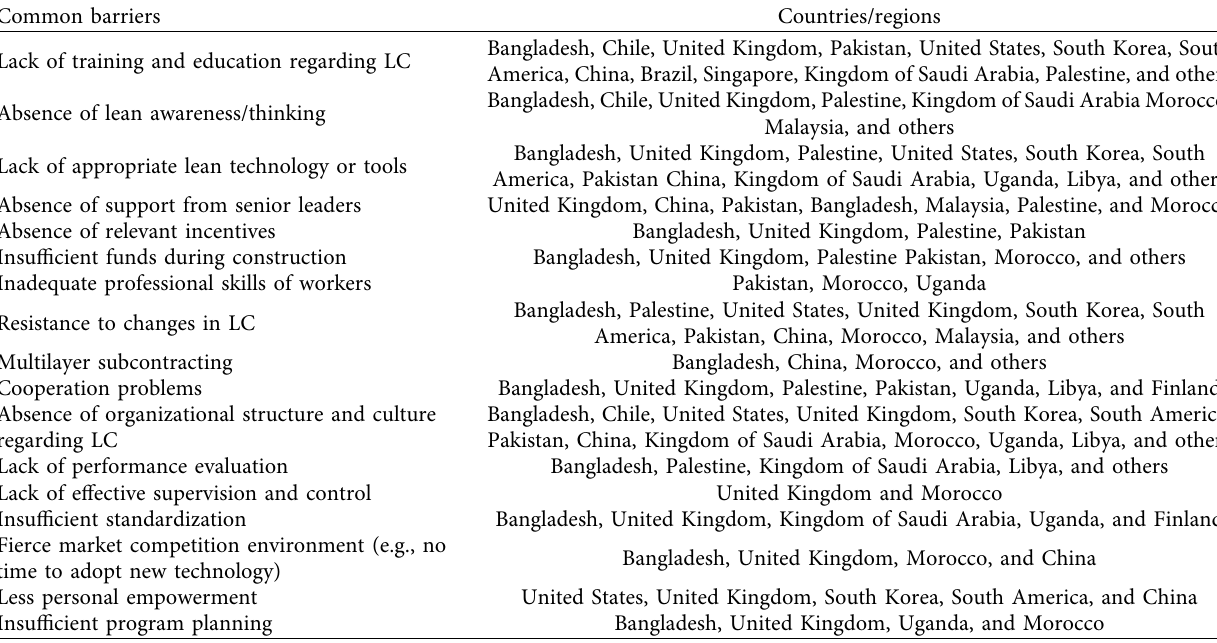
Table 1: Countries/regions and their common barriers involved in previous studies